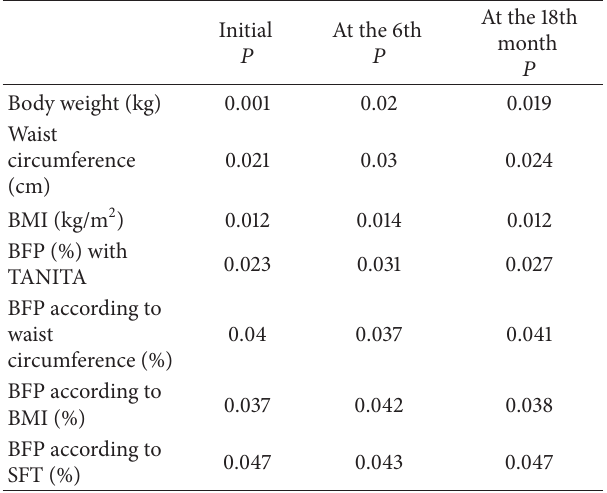
Table3:Thecomparisonoftwogroupcharacteristicsduringfollow-